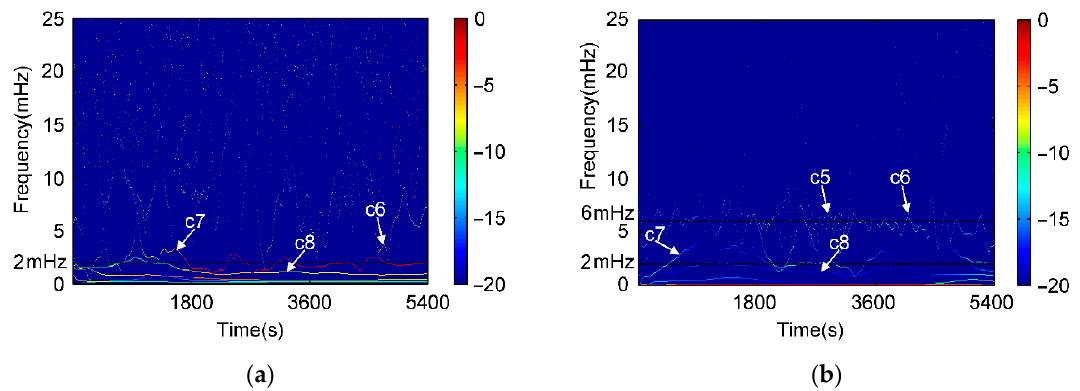
Figure 10. Time-frequency spectrums of IMFs for CMC . ( a ) C09 and ( b ) G19.